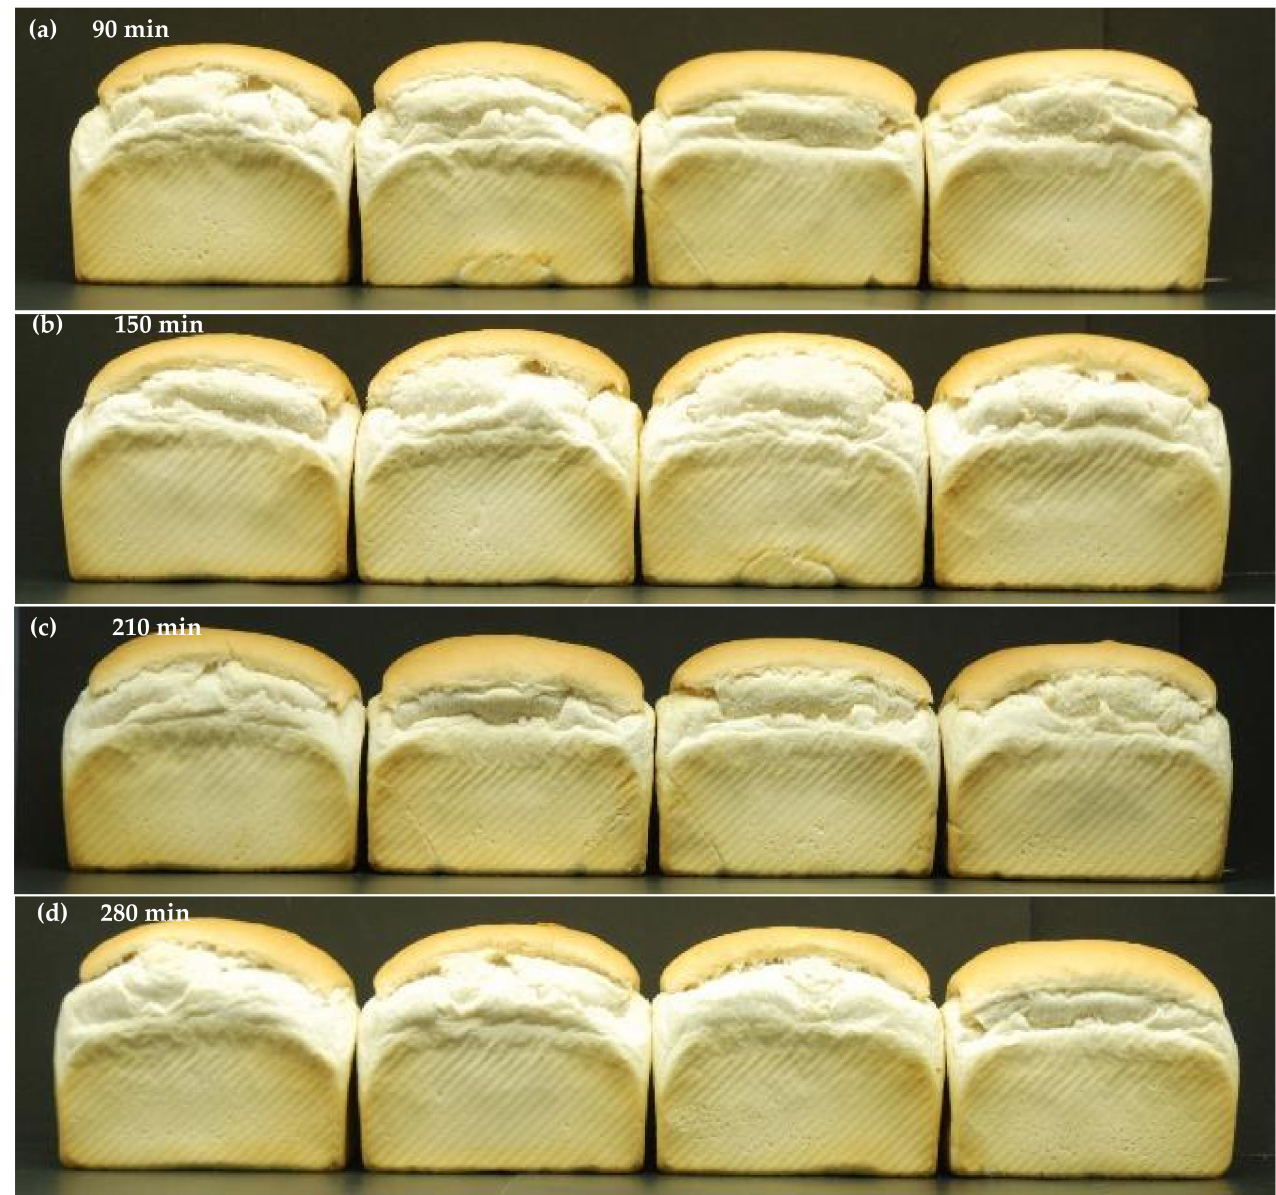
Figure 8. Breads made with ferment prepared using varying fermentation times. ( a ) 90 min, ( b ) 150 min, ( c ) 210 min, and ( d ) 280 min. Left to right: control (no ferment), 30% ferment inclusion, 50% ferment inclusion, and 70% ferment